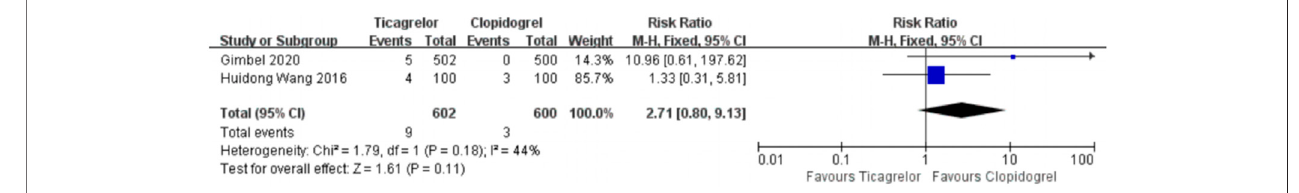
FIGURE 6 | Meta-analysis with RR and 95% CI for fatal bleeding. Boxes are the relative risk estimates from each study; the horizontal bars are 95% CI. The size of the box is proportional to the weight of the study in the meta-analysis. HR, hazard ratio; RR, risk ratio; CI, con fi dence interval.